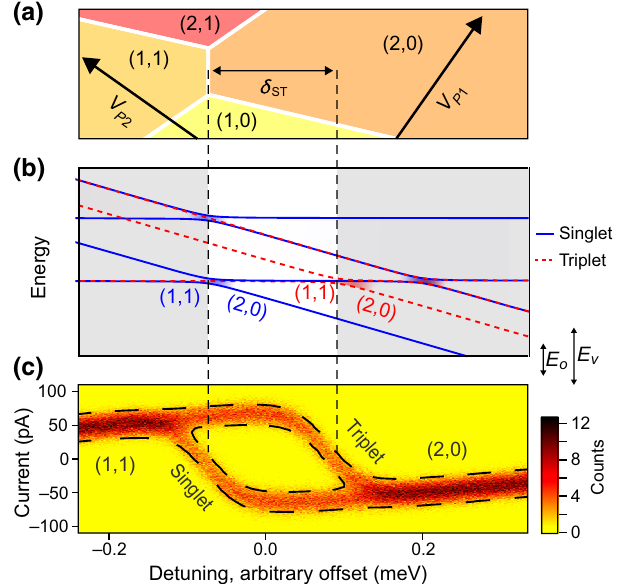
FIG. 2. The charge stability, energy levels, and spin-blockade spectroscopy. (a) The charge-stability diagram in the bias region relevant for measurement, showing the ground-state charge occu- pancy (color) as a function of the bias. The horizontal axis reflects the double-quantum-dot- (DQD) bias difference and the vertical axes represent the DQD-bias common mode. (b) The energy-level diagram near the measurement window, shown at zero magnetic field for clarity. The horizontal lines (energy inde- pendent of detuning) represent the (1,1) charge state used for exchange and idle operations, while the diagonal lines represent the (2,0) charge state. In this illustration, the relevant singlet- triplet splitting δ ST (and, accordingly, the region of spin-to-charge conversion) is set by the 2 e orbital energy ( E o ) rather than the excited valley-state energy ( E v ). (c) Spin-blockade spectroscopy, showing histograms of the DCS current as a function of the detuning between the (2,0) and (1,1) charge states. The fully resolved gap between the singlet and triplet branches is reflective of highly efficient spin-to-charge